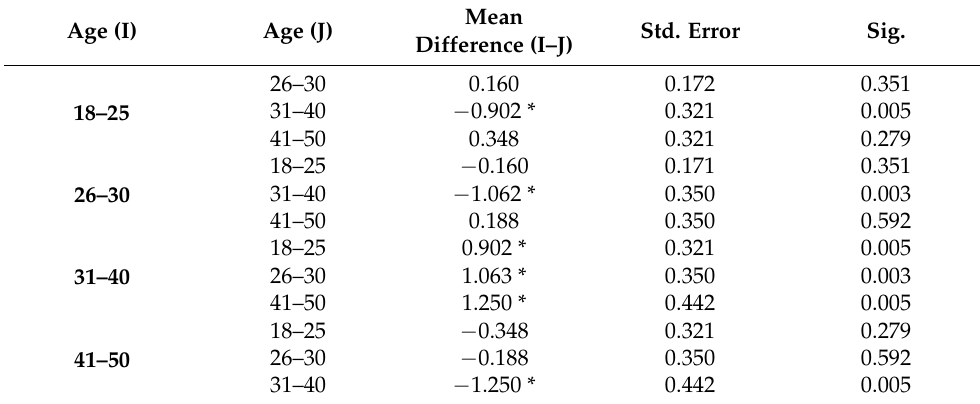
Table 10. Multiple